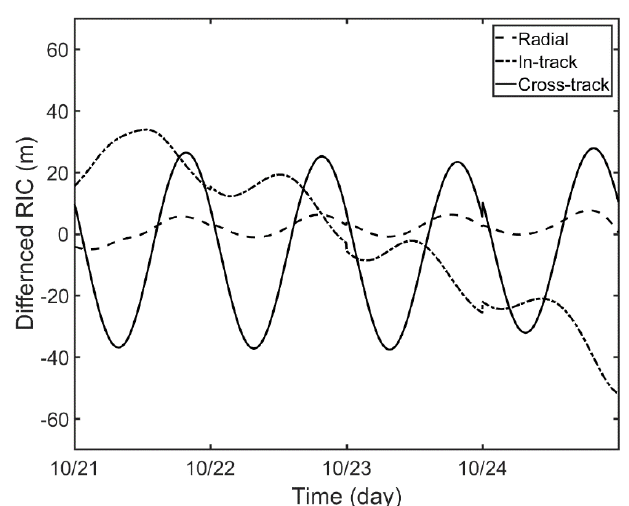
Figure 12. Orbit overlap differences between the estimated orbits and GeoForschungsZentrum (GFZ) final orbits.